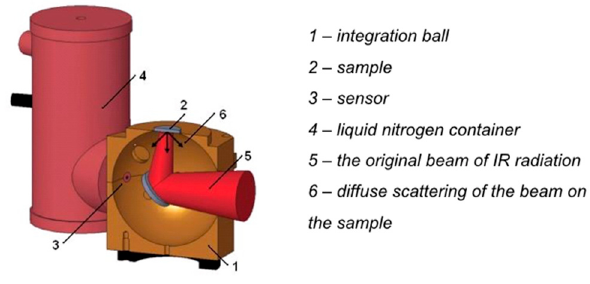
Figure 2. Scheme of the spectral reflectance measurement.